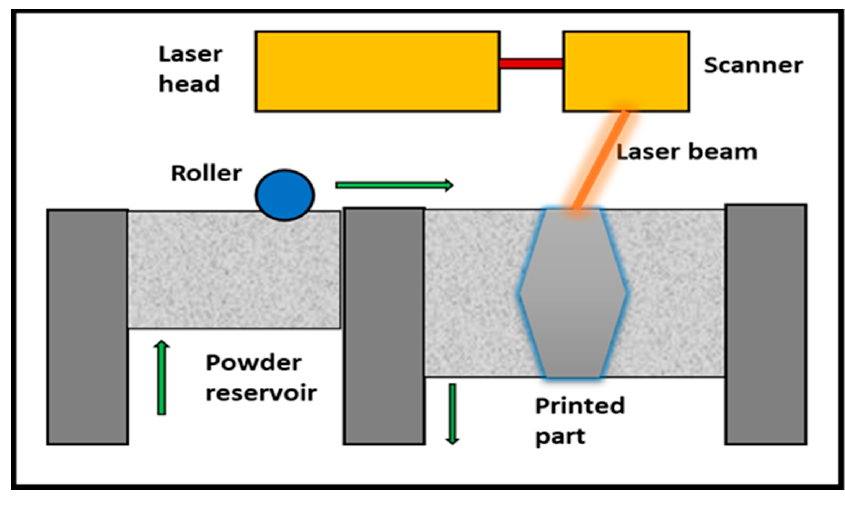
Figure 1. Schematic of SLM.